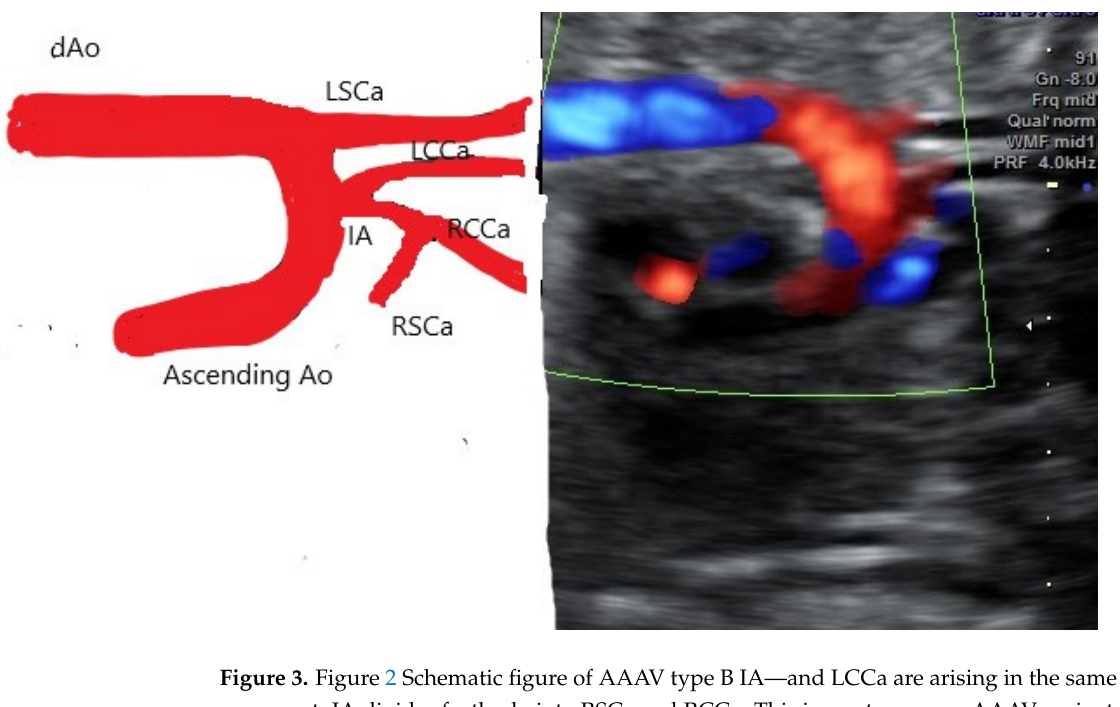
Figure 2. Schematic figure of AAAV type A IA—innominate artery as a common trunk from which three vessels is branching LCCa, RSCa and RCCa.